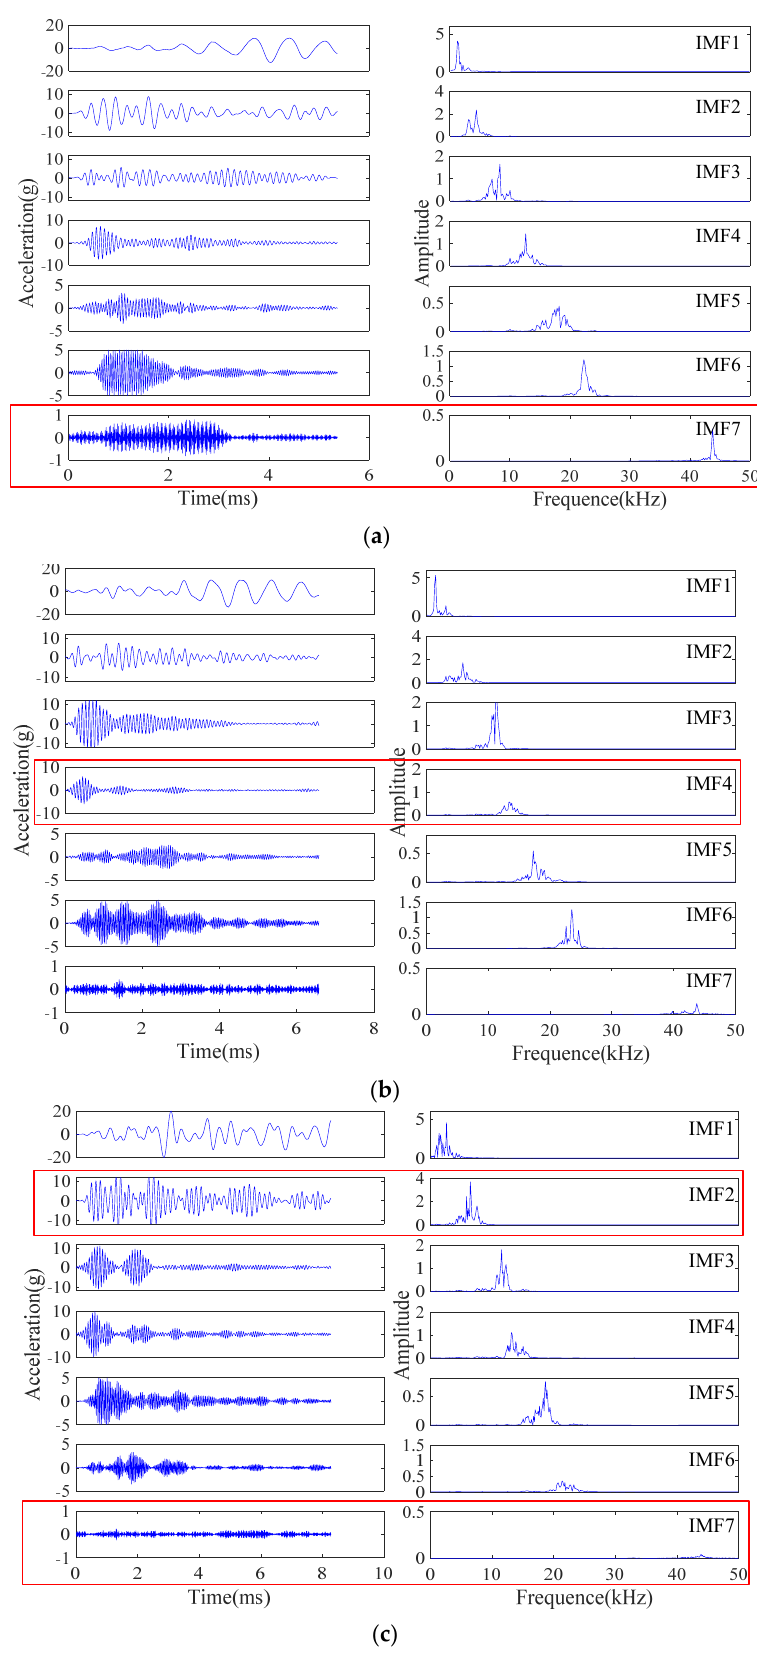
Figure 7. IMFs of the vibration signals under different faults. ( a ) Fault1 (coil-plunger jam). ( b ) Fault2 (poor contact). ( c ) Fault3 (jam in the open latch).